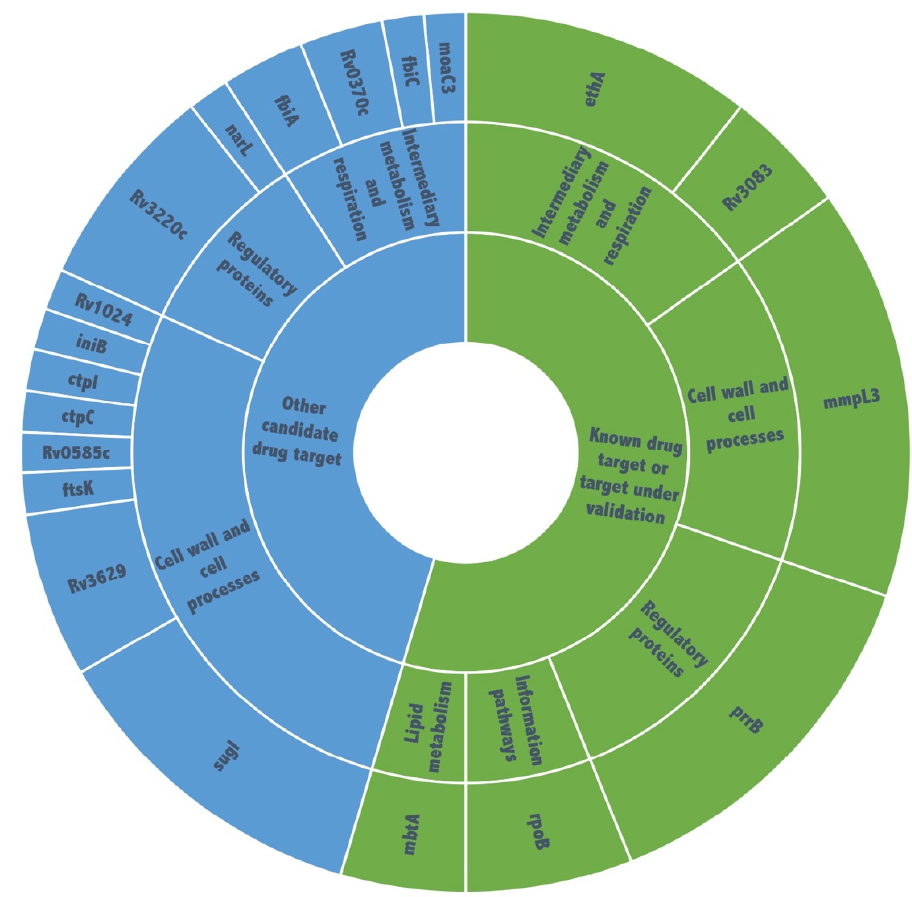
Figure 3. Function of candidate target genes identified from Mycobacterium tuberculosis H37Rv mutants.